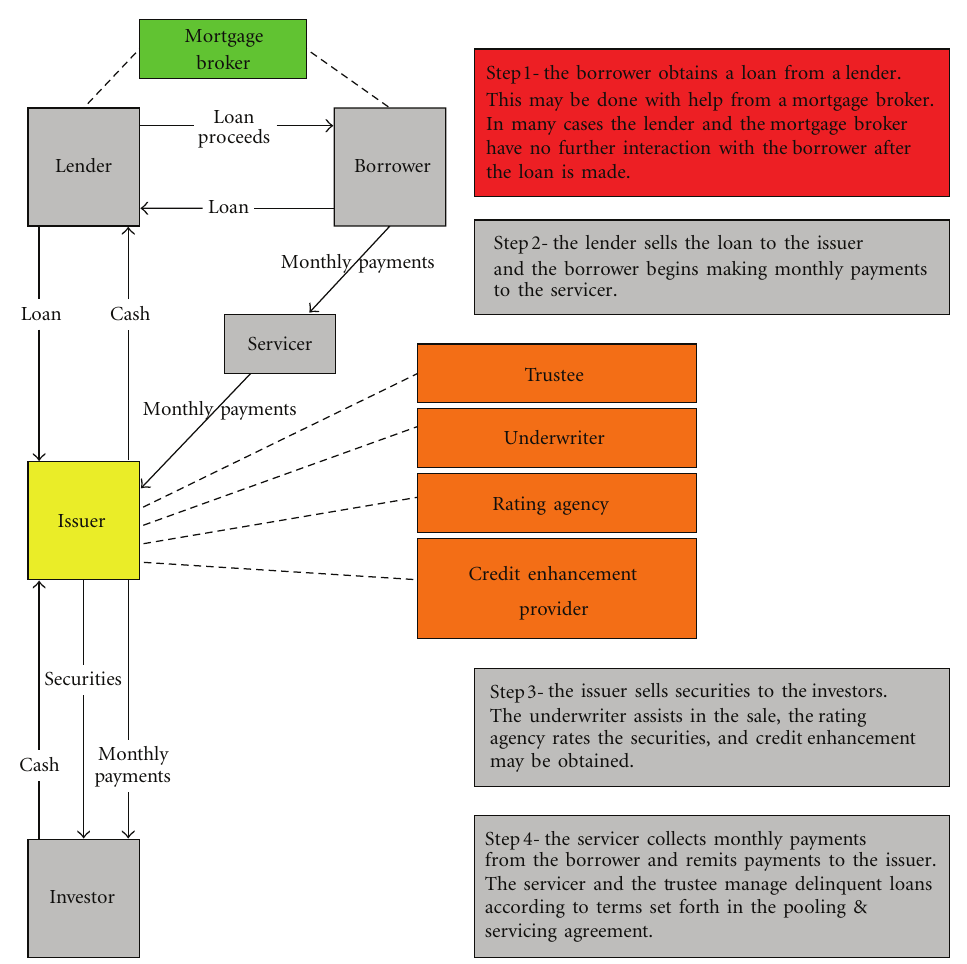
Figure 9: Diagrammatic overview of borrowing under securitization strategies (cid:2) compare (cid:5) 51 (cid:6)(cid:3) .